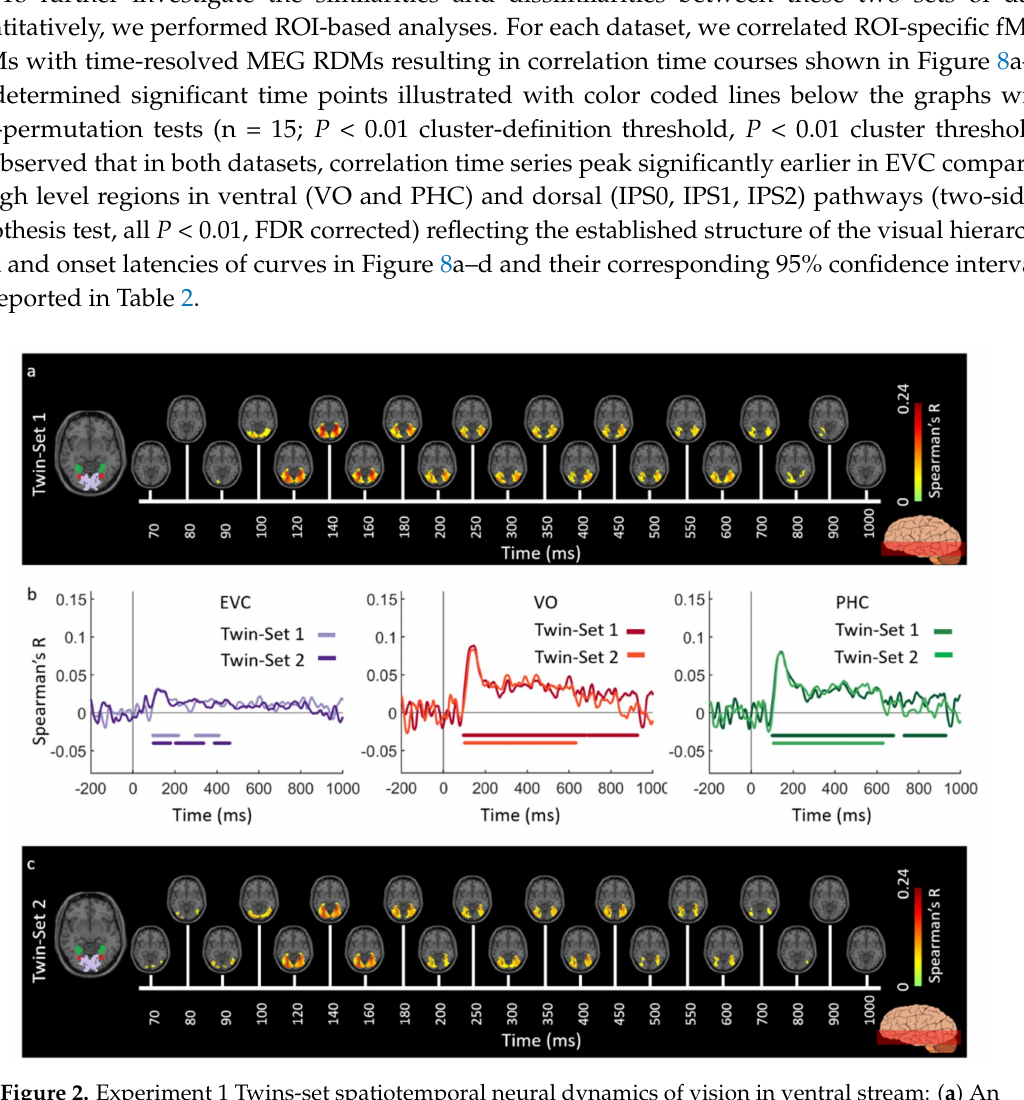
Figure 2. Experiment 1 Twins-set spatiotemporal neural dynamics of vision in ventral stream: ( a ) An axial slice encompassing early visual cortex (EVC) and ventral ROIs, ventral occipital (VO) area and parahippocampal cortex